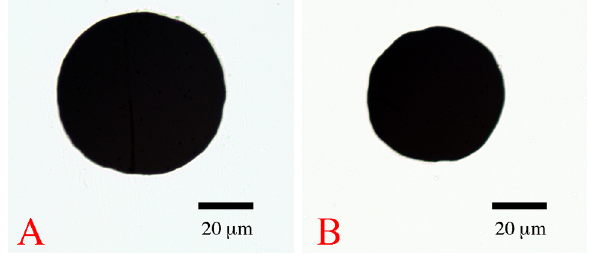
Figure 2. Images of the circular dots of the intermediate mask shown in Figure 1.